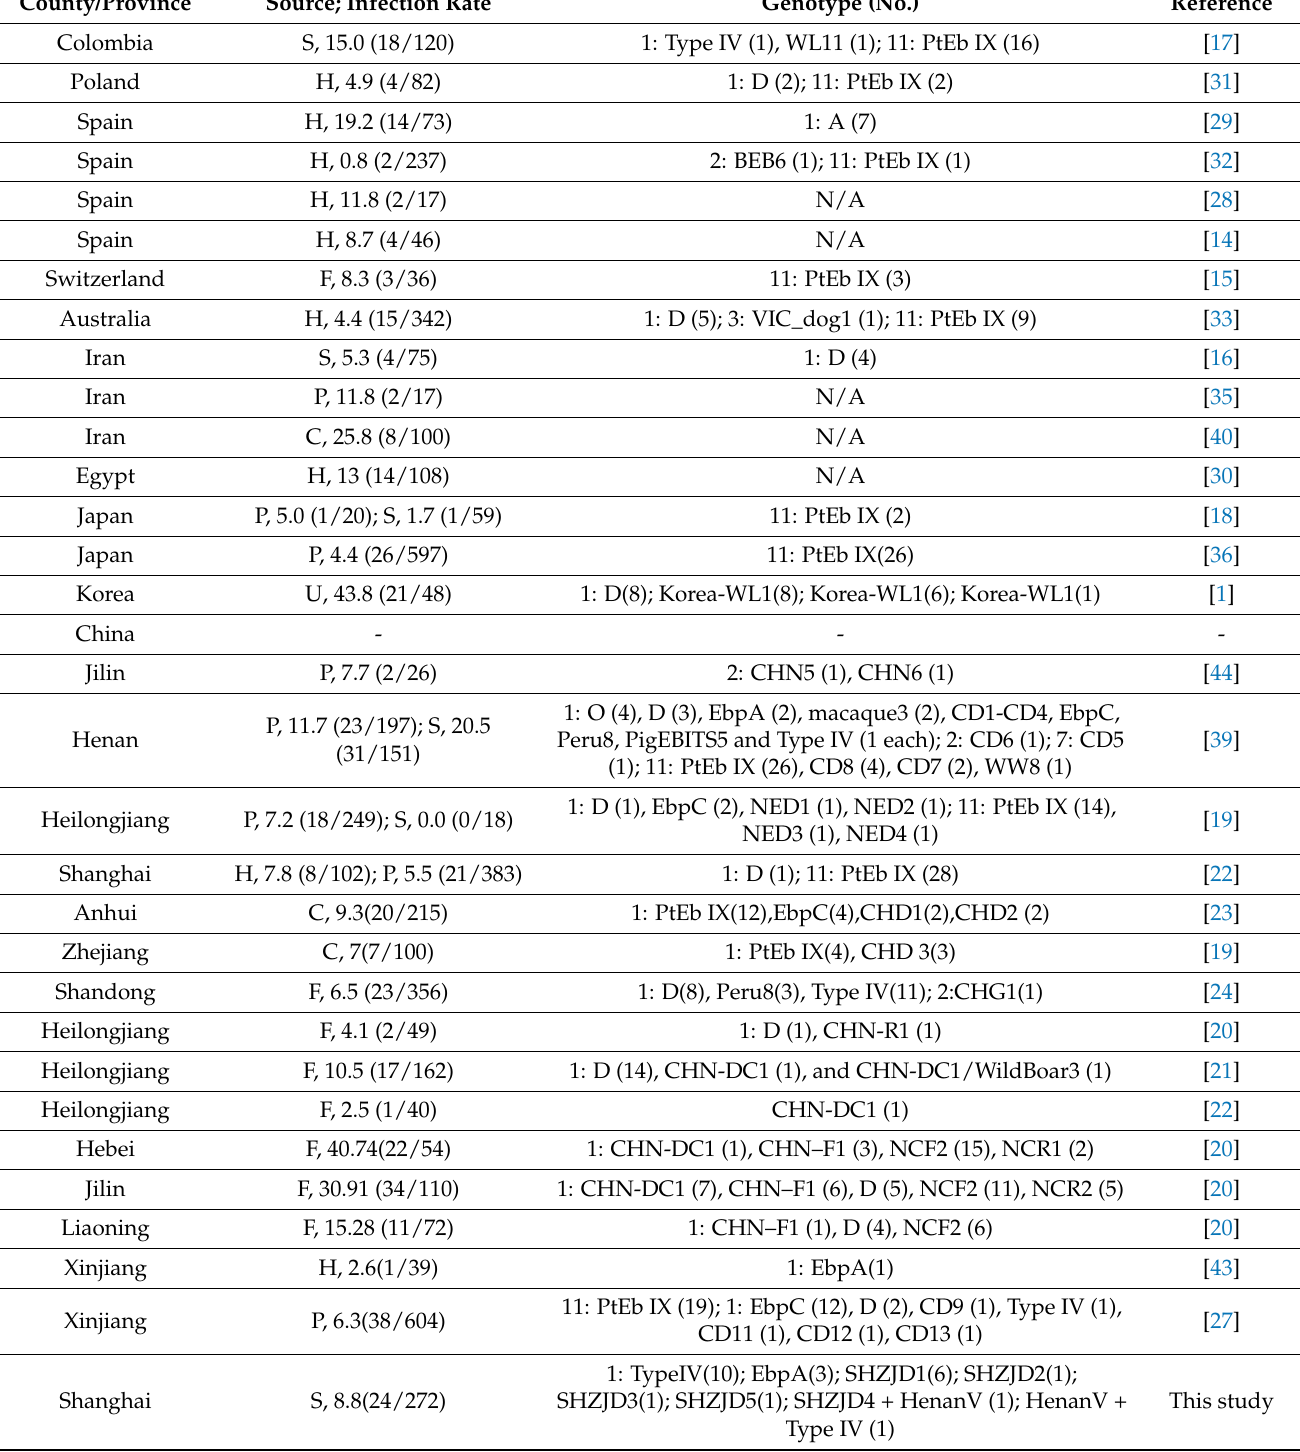
Table 3. Prevalence and genotype distribution of Enterocytozoon bieneusi in dogs worldwide.